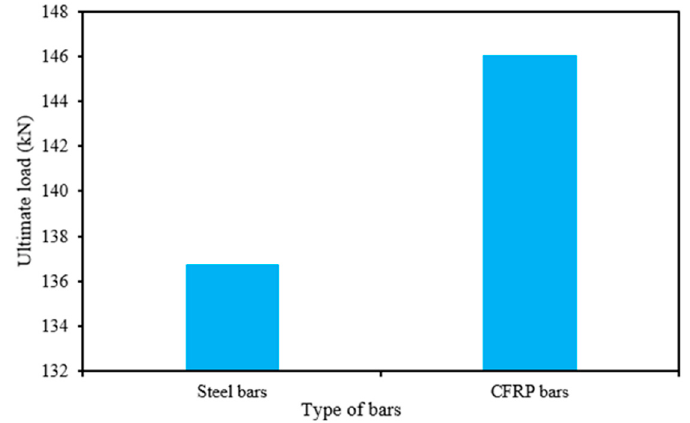
Figure 11. The effect of type of NSM reinforcement.